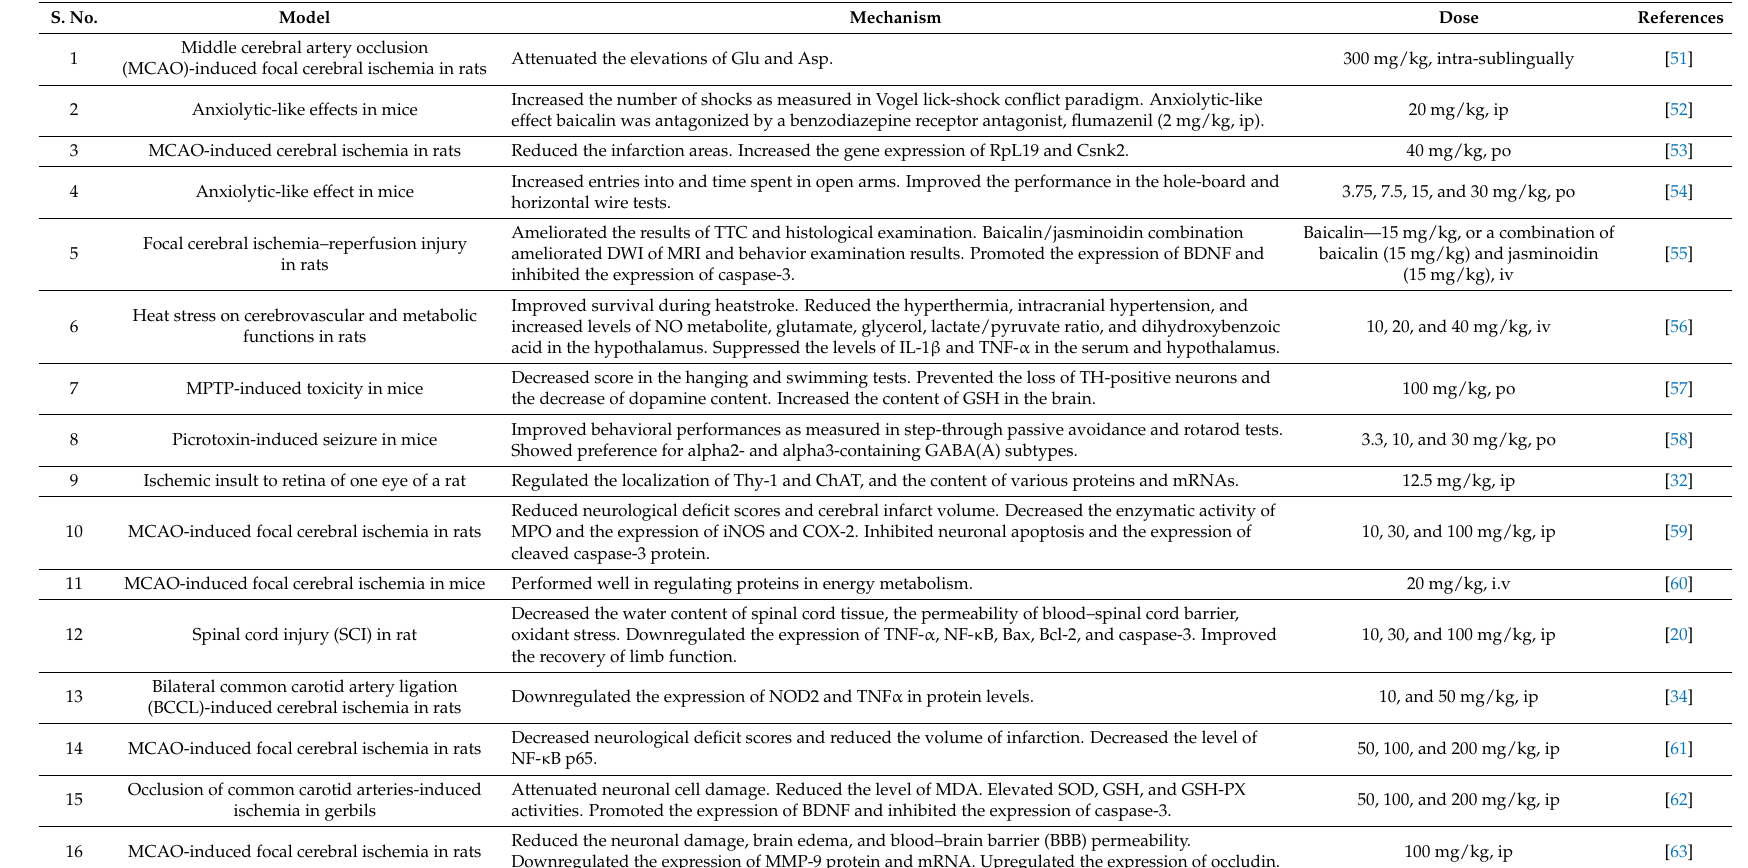
Table 2. Neuroprotective effects of baicalin under in vivo